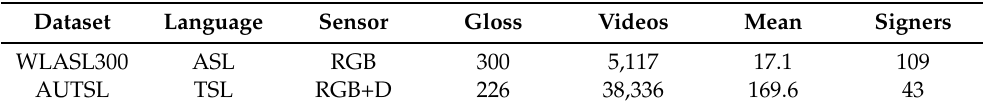
Table 1. Overview of the datasets. Column “Mean” refers to the average number of video instances per gloss